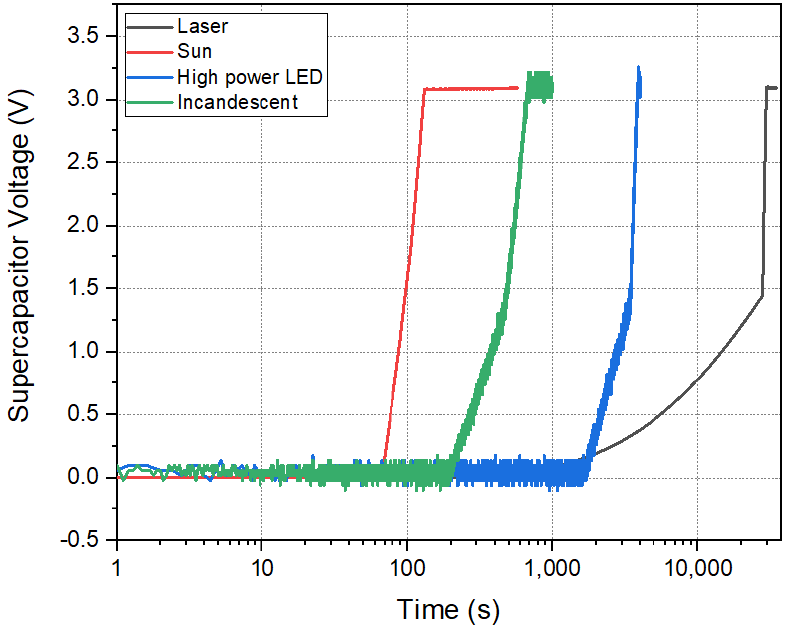
Figure 5. A 470 mF supercapacitor charging using sunlight and various light sources placed 30 cm from the solar